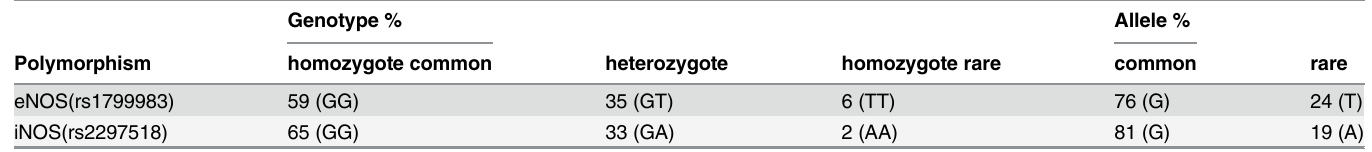
Table 2. The genotype distributions and allele frequencies in 167 patients for eNOS G894T (rs1799983) and in 166 patients for iNOS G2087A (rs2297518) out of 172 patients with acute Puumala hantavirus infection *